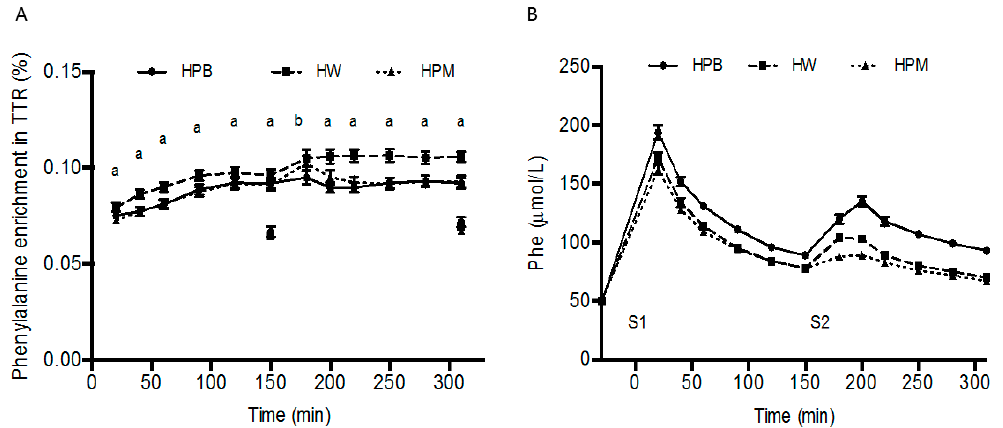
Figure 2. Mean ± SEM tracer enrichments (tracer-to-tracee ratio (TTR)) in plasma (p) (dots with lines) and muscle (dots at 150 and 310 min only) following the flood-primed continuous infusion with [ ring - 13 C6] phenylalanine ( A ), and p-phenylalanine concentrations after consumption of serving 1 and serving 2 ( B ), n =18. (A) a HW significantly different from HPB and HPM, p < 0.05. b HPB significantly different from HPM, p < 0.05. Data on TTR were analyzed using linear mixed-effects models with a time-treatment interaction and treatment order and age as fixed effects and with subject-specific random effects. Data on p-phenylalanine were analyzed as area under the curve (AUC): AUC serving1 and AUC serving2 using a linear mixed-effects model with a serving-treatment interaction and with treatment order and age as fixed effects and with subject-specific random effects. HPB, hydrolyzed porcine blood protein; HPM, hydrolyzed porcine muscle protein; HW, hydrolyzed whey protein.